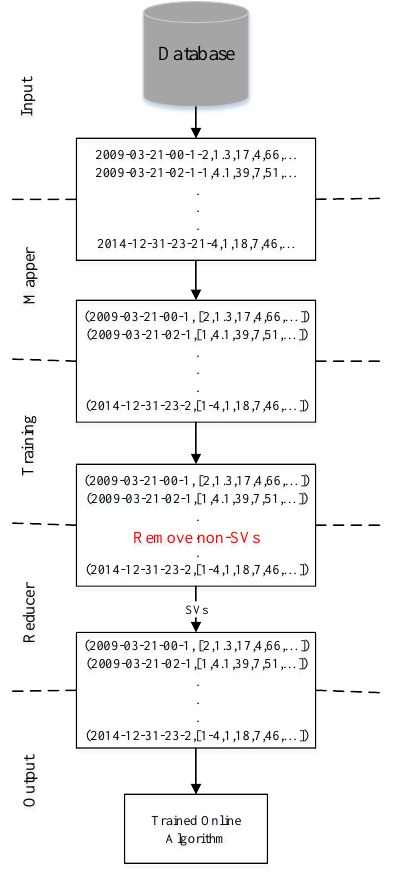
Figure 3. Transfer of data within map and reduce